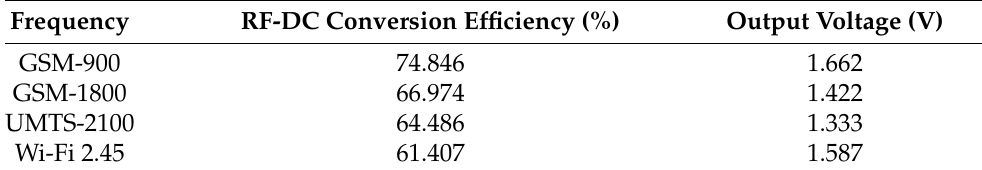
Figure 14. Output voltage of the proposed quad-band circuit with a single receiving antenna for the load of 5 k Ω . Table 2. Recorded results for the first scenario under 0